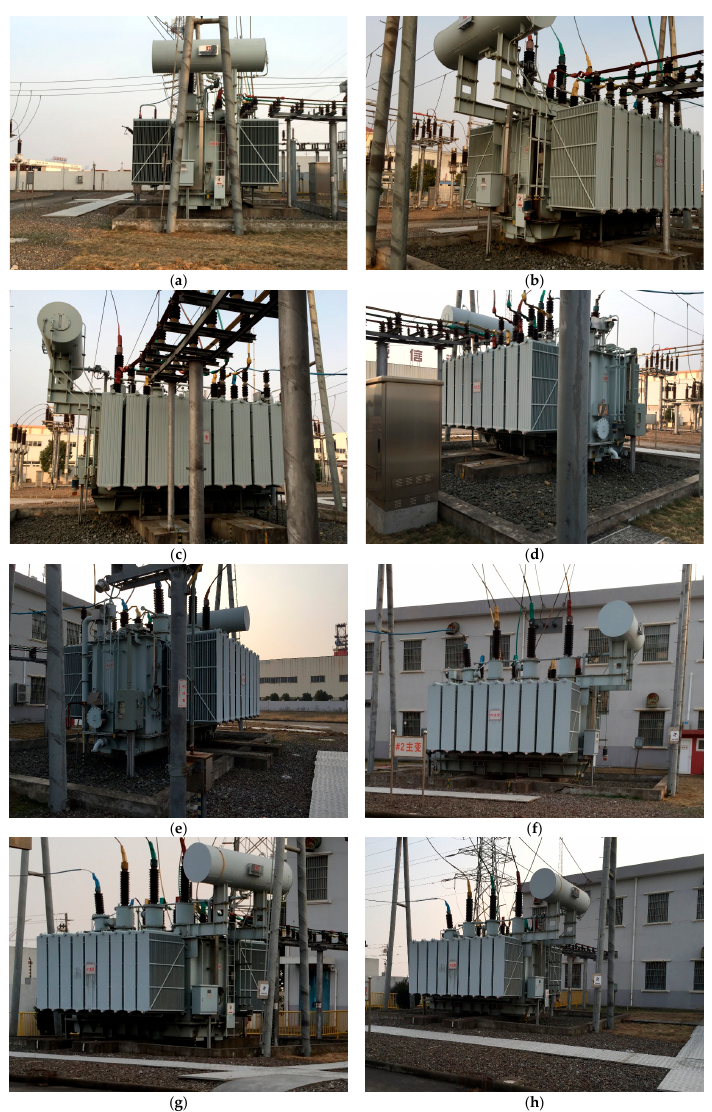
Figure A1. Parts of the images in the data set. ( a ) A frontal shooting angle; ( b ) A relatively frontal shooting angle; ( c ) A lateral shooting angle; ( d ) A relatively back shooting angle; ( e ) A relatively back shooting angle; ( f ) A lateral shooting angle; ( g ) A relatively frontal shooting angle; ( h ) A relatively frontal shooting